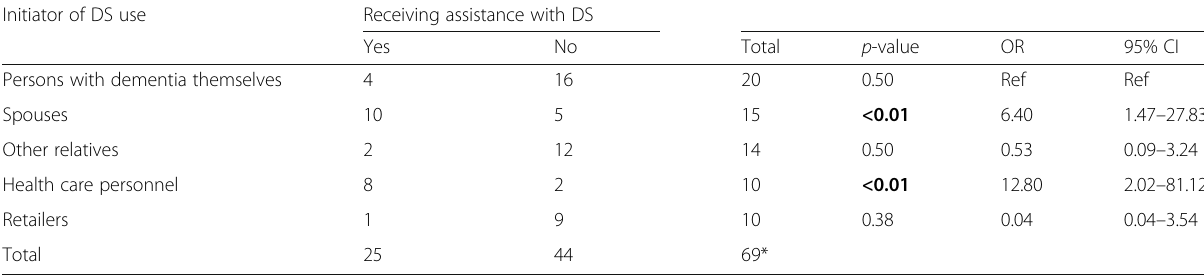
Table 3 The relationship between assistance with DS administration and who initiated the use of DS calculated by logistic regression analysis Initiator of DS